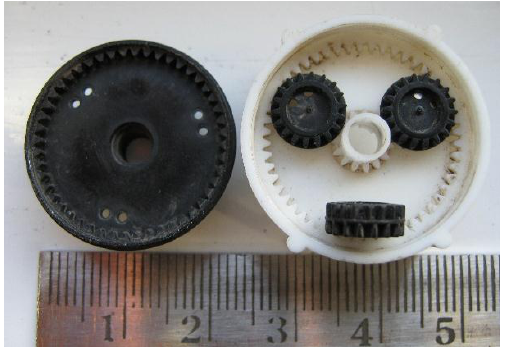
Figure 3. Rear-view mirror drive gearbox, reproduced from [46].